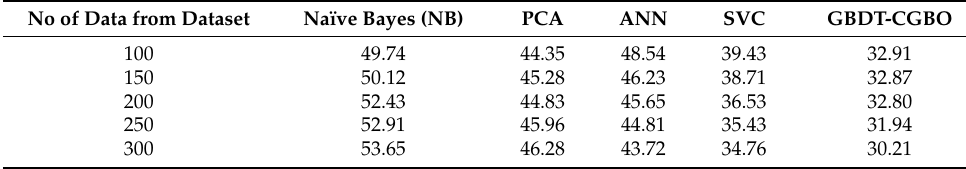
Figure 5. RMSE Analysis of GBDT-CGBO method with existing system. Table 4. RMSE Analysis of GBDT-CGBO method with existing system in percentage.